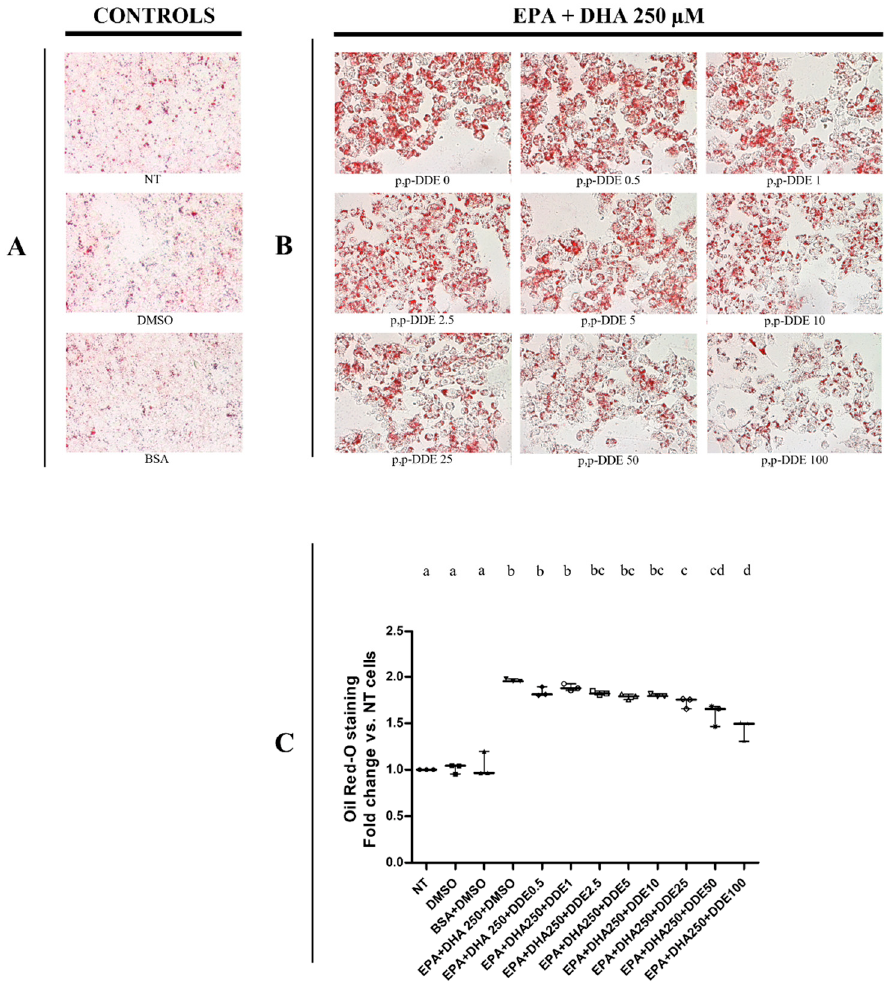
Figure 5. Total lipid content in response to different doses of DDE co-incubated with EPA/DHA mixture. ( A ) representative images of lipid depots in control cells (NT, DMSO, BSA); ( B ) representative images of cells treated with EPA + DHA or with EPA + DHA and increasing DDE doses. Original image magnification used: 40×. Quantitative analyses were obtained quantifying oil Red-O accumulation in cells. Oil-Red O quantifications were measured spectrophotometrically (490 nm). Data graphically represented as median with range for 3 biological replicates ( C ). Three different control groups of cells were tested (non-treated cells, NT; DMSO and BSA) to evaluate the specific effect of DDE on fatty acid deposition. Statistical analyses were performed by using GraphPad Prism software. One-way ANOVA analysis was followed by Bonferroni’s post-hoc test: different letters indicate statistically different values.